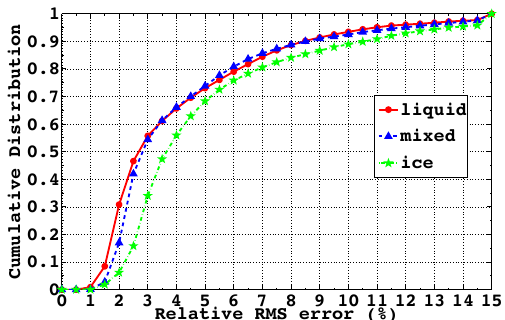
Figure 8. Cumulative distributions of the relative RMS errors for the sigmoidal fits over cloudy land using CERES Terra